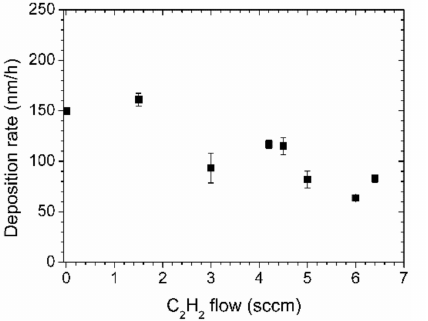
Figure 2. Deposition rates of nitrogen-containing diamond-like carbon (N-DLC) films prepared by aniline and